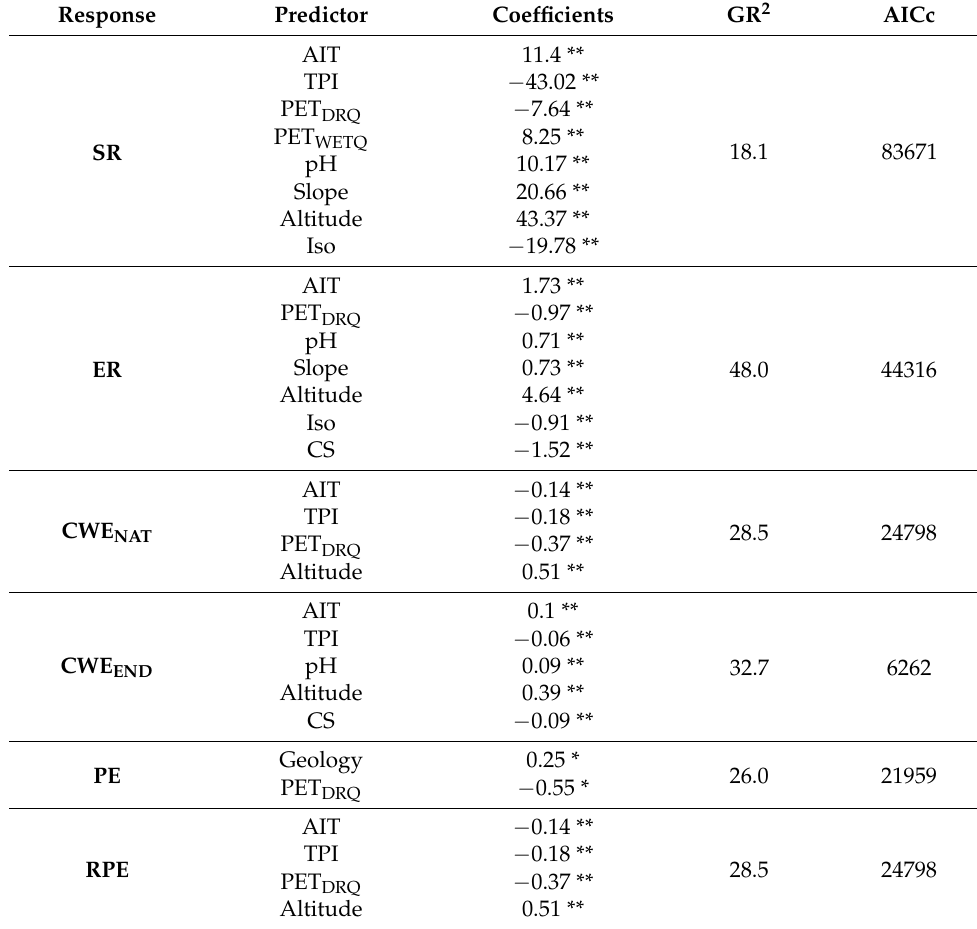
Table 1. Best spatial autoregressive error models (SAR err ) for the relationships among the number of native (SR) and endemic (ER) taxa, corrected weighted endemism of the native (CWE NAT ) and the endemic taxa (CWE END ), phylogenetic endemism (PE), relative phylogenetic endemism (RPE) and the predictor variables. GR 2 : Gelkerke pseudo-R-squared. AICc: Akaike Information criterion corrected for small samples. Asterisks denote: * p < 0.05, ** p < 0.001. AIT: Thornthwaite’s